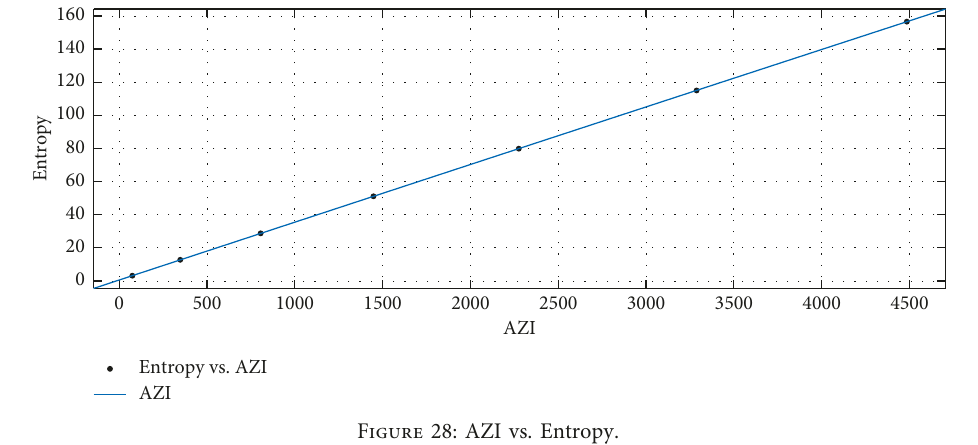
Figure 28: AZI vs. Entropy.